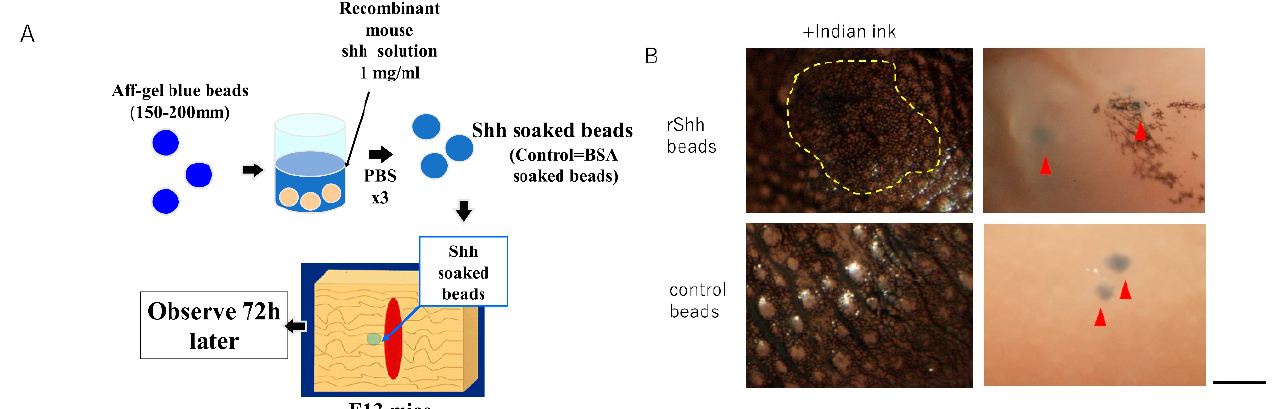
Figure 3. Transplantation of recombinant Shh-containing beads into E13 mice. ( A ) Schematic of the experiment. ( B ) Wound 72 h after bead implantation. Red arrows indicate the transplanted beads. Bar = 1 mm.